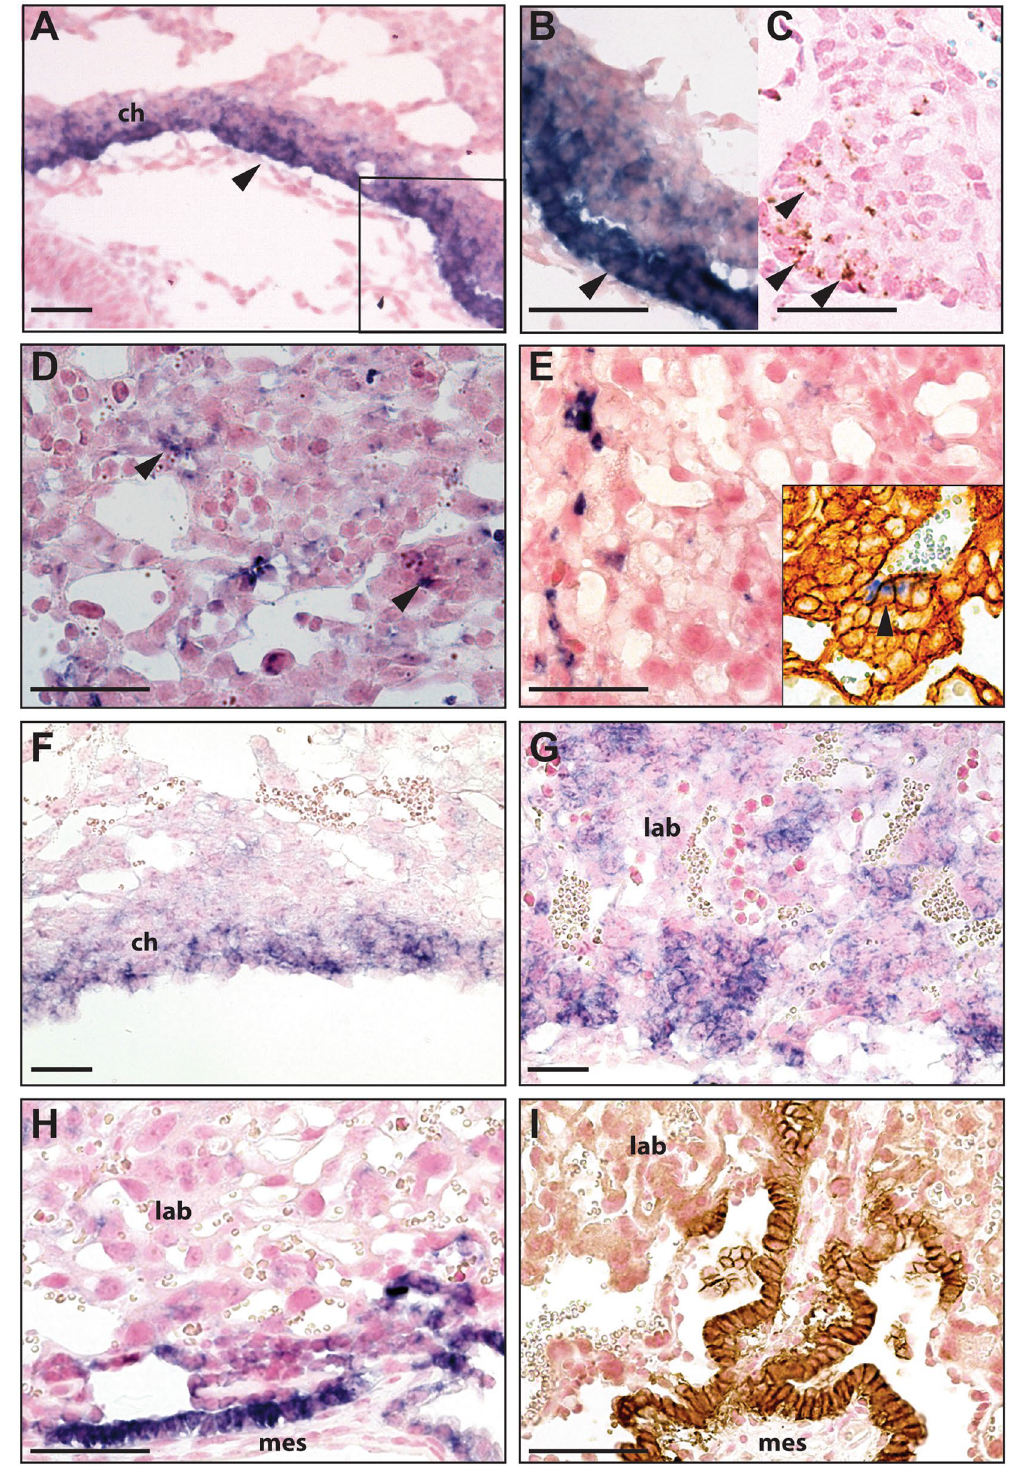
Figure 6. Sca-1 was expressed in the chorion of the mouse placenta at E8.5 ( A ; arrow). The inset in ( A ) is shown at higher magnification in ( B ) and from a serial section in ( C ), where protein expression is indicated by arrows. Controls in which no primary antibody was used showed no positive staining (not shown). Sca-1 was expressed in the labyrinth at E10.5 ( D ) and E16.5 ( E ). The inset in ( E ) shows Sca-1 expression (arrowhead, blue; ISH) in cytokeratin positive trophoblast of the labyrinth (brown; IHC). Epcam mRNA expression was also detected in the chorion and appeared to overlap with Sca-1 expression at E8.5 ( F ). At E10.5, Epcam expression was more broadly expressed in the labyrinth than Sca-1 ( G , compare with D ) but by E16.5, both Epcam mRNA and protein were appreciably reduced however still present in more cells in the labyrinth than Sca-1 ( H , I , compare with E ). ch, chorion; mes, embryonic mesoderm; lab, labyrinth. Scale bar = 100